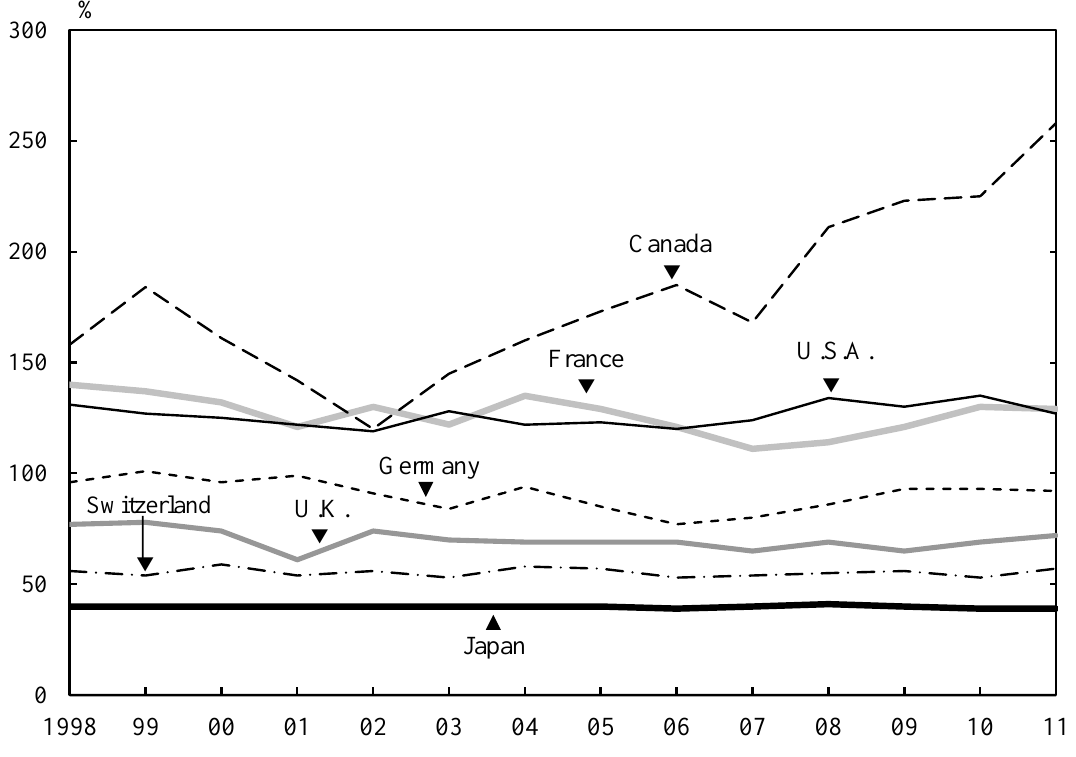
Trends in Food Self-Sufficiency Rates of Major Countries 1) (In terms of